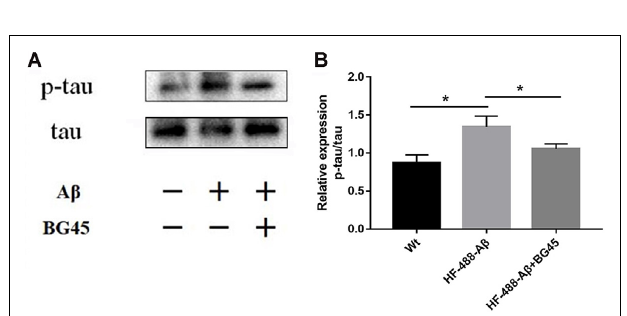
FIGURE 6 | BG45 decreased the phosphorylation of tau. (A) Representative bands of the expression of p-tau/tau from control mice, HF-488-A β group and HF-488-A β + BG45 group. (B) Quantification of PSD-95 is normalized to tau and is shown as a % of control. Compared with the control group, exogenous A β treatment increased the phosphorylation level of tau protein. Compared with the HF-488-A β group, the phosphorylation level of tau protein in the HF-488-A β + BG45 group was lower. n = 5. * p <